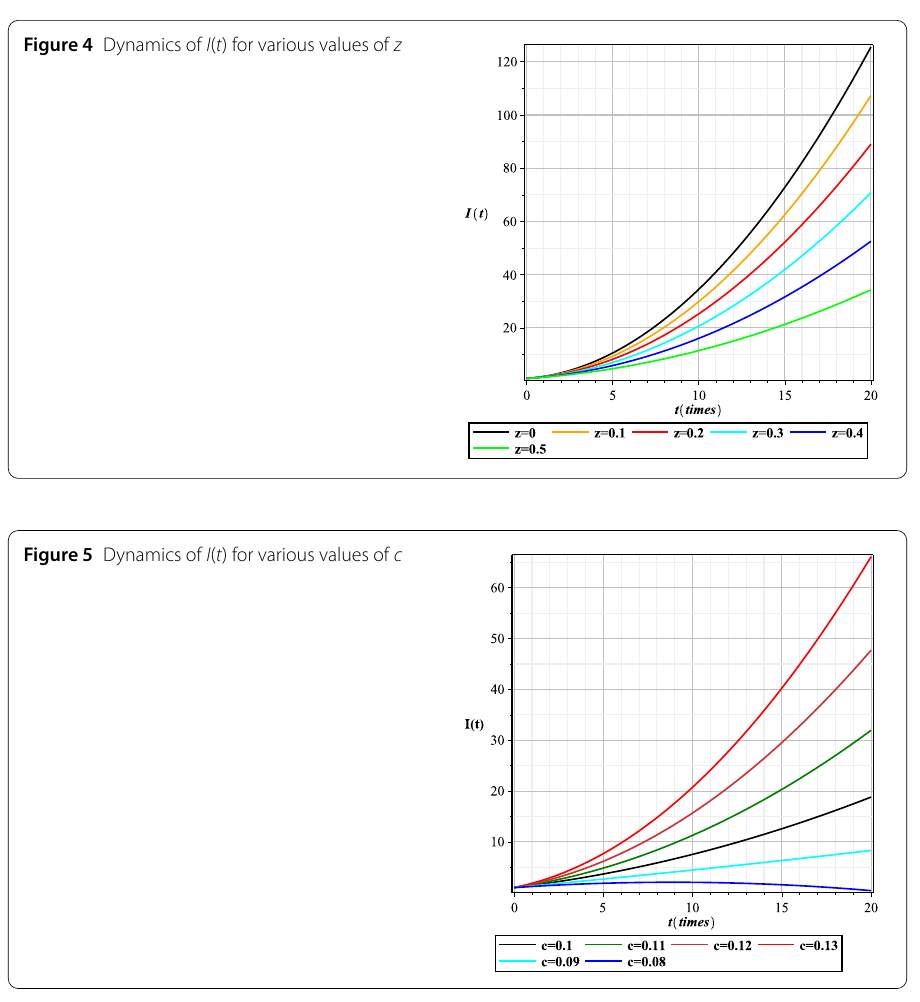
Figure 4 Dynamics of I ( t ) for various values of z